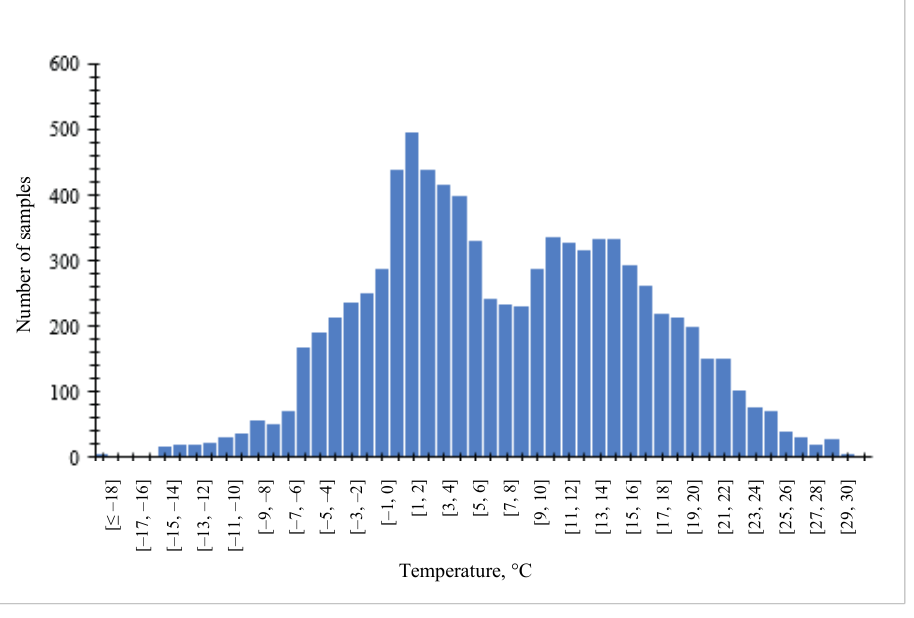
Fig. 2. Temperature distribution 2019 in